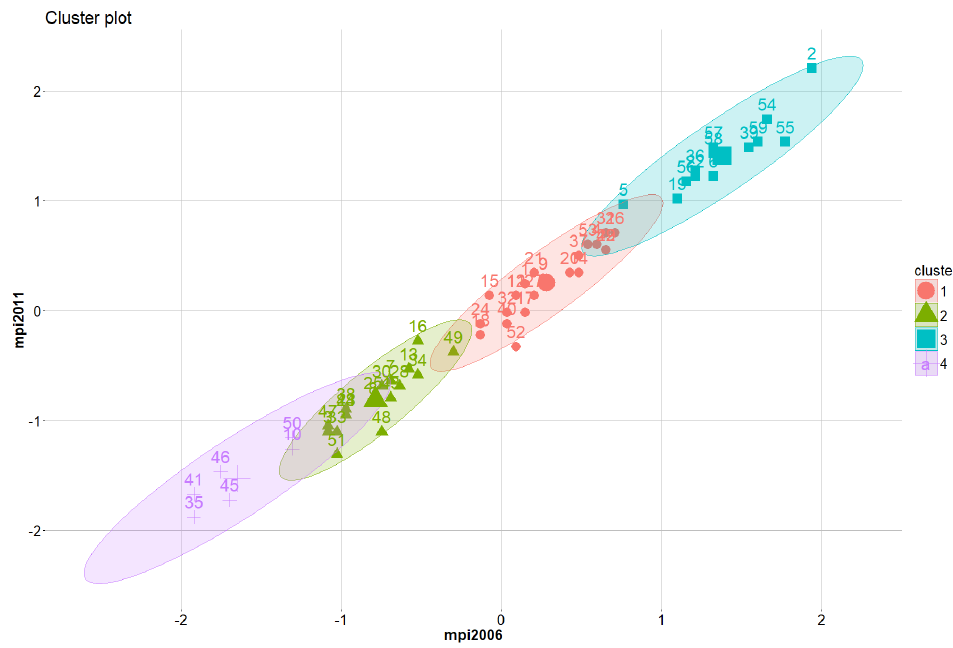
Figure 3: Scatter plots for k-means clusters’ solutions – k = 4